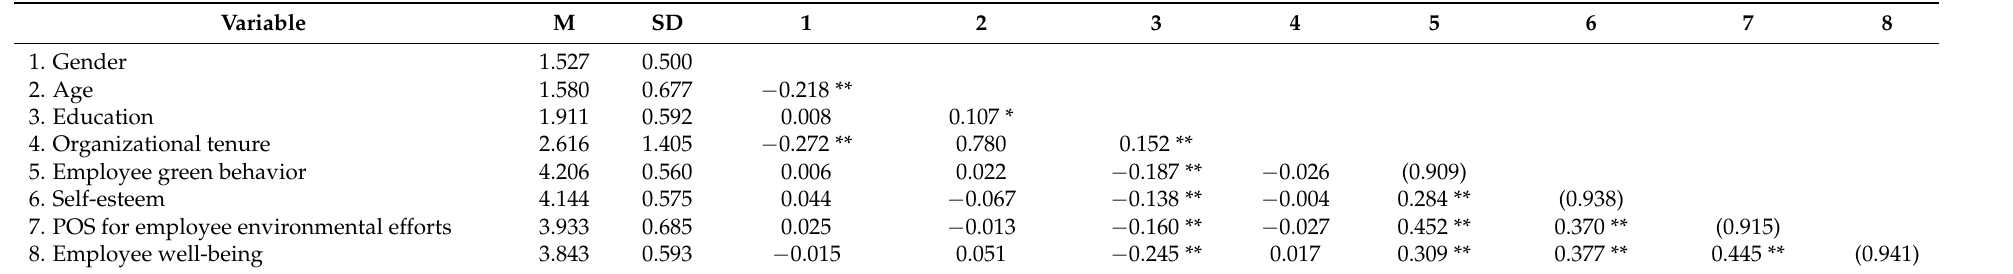
Table 3. Descriptive statistics and inter-correlations.